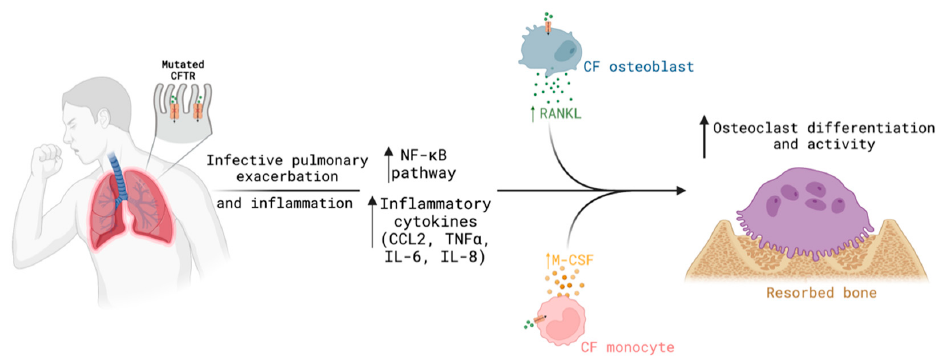
Figure 4. CFTR dysfunction and recurrent pro-inflammatory environment potentiates osteoclast formation and activity, contributing to bone loss and higher risk of fractures. Scheme was created using Biorender.com (www.biorender.com; access on 9 December